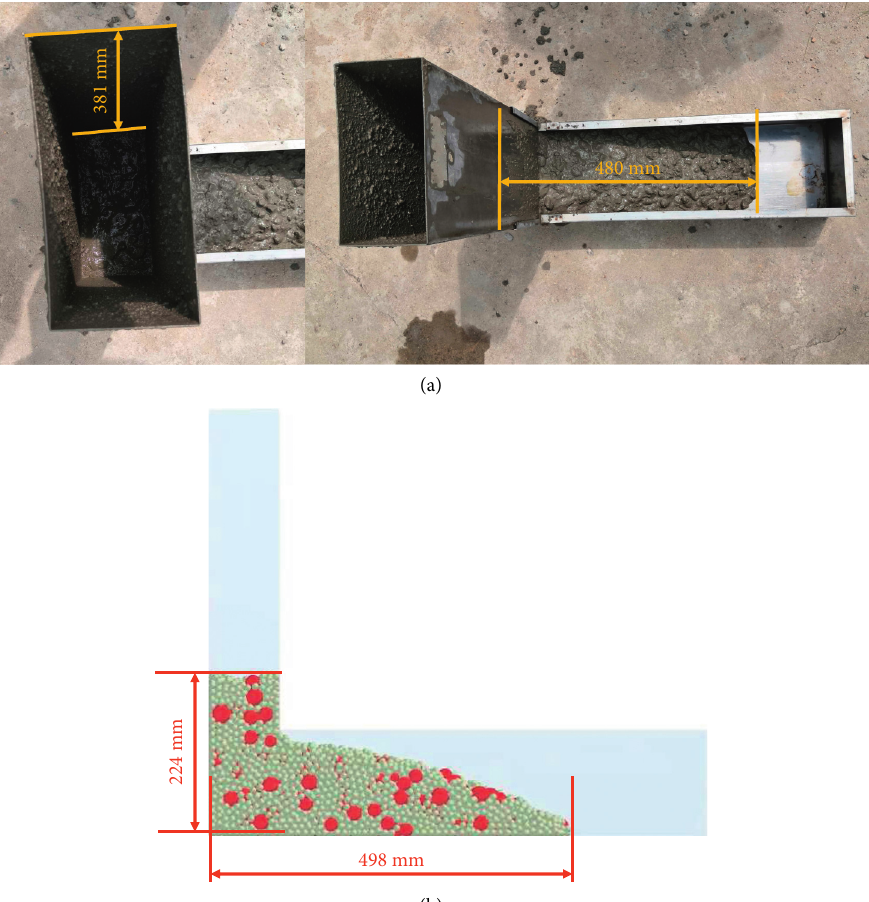
Figure 6: The results of L-box tests in experiments (a) and simulations